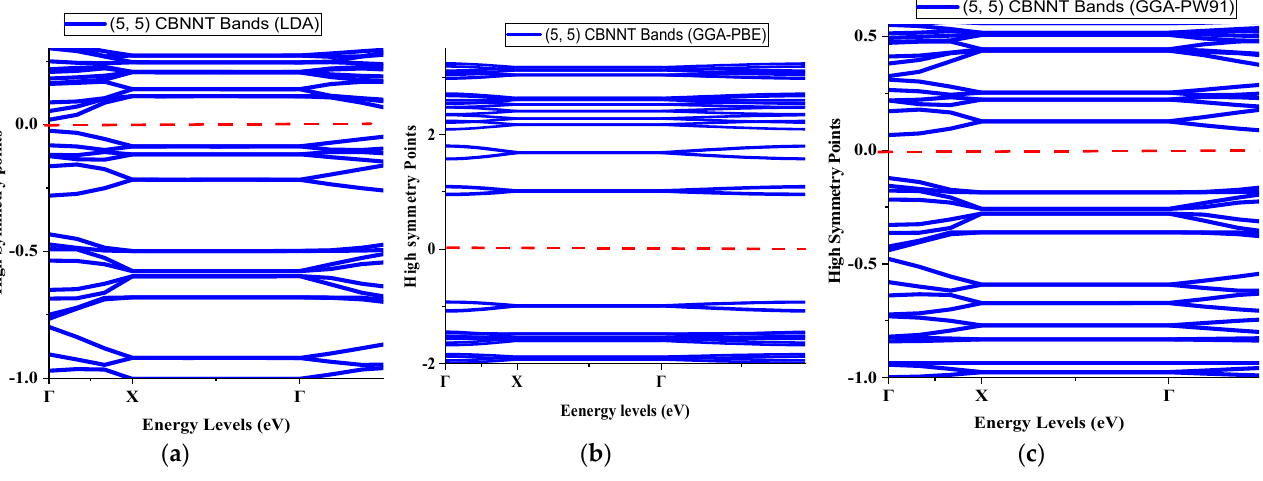
Figure 2. Bands structures of (5, 5) SWCBNNT ( a ) LDA ( b ) PBE ( c ) PW91.